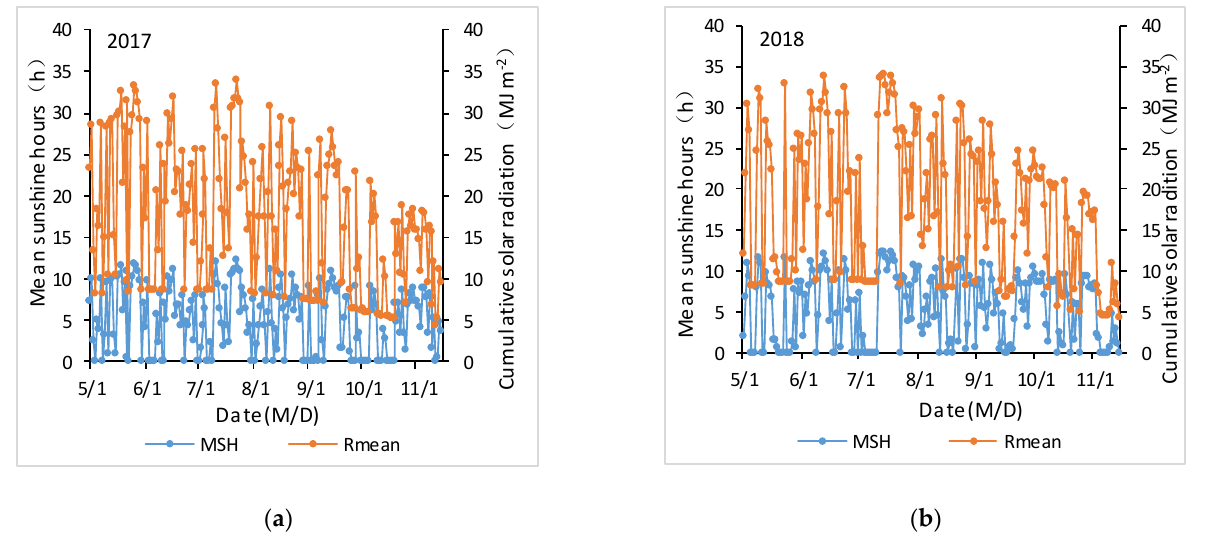
Figure 2. Variation of mean sunshine hours during rice growing season. MSH: mean sunshine hours; R mean : mean daily solar radiation; ( a ): 2017; ( b ): 2018.